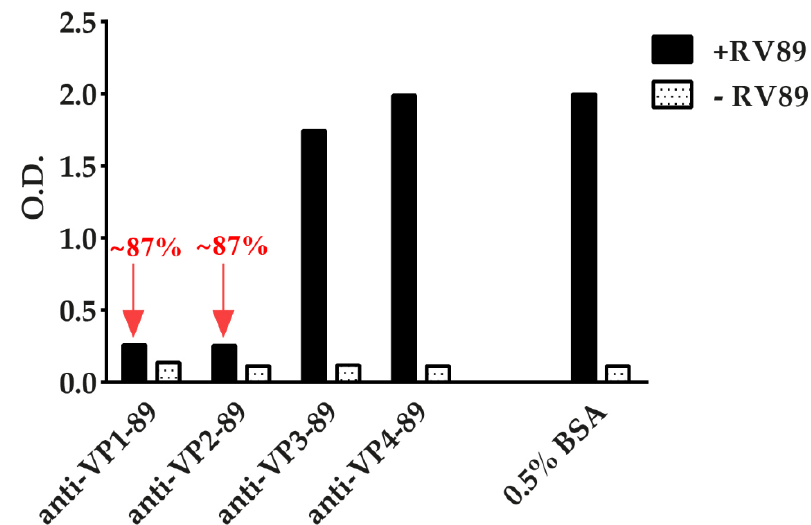
Figure 8. Inhibition of RV89 binding to ICAM-1 by antibodies specific for each of the four viral capsid proteins (VP). Binding of RV89 to ICAM-1 after pre-incubation of virus with antibodies against VP1, VP2, VP3, and VP4 compared to pre-incubation with buffer containing BSA only reported as O.D. (y-axes). The inhibitions of RV89 binding by anti-VP1 and anti-VP2 antibodies are indicated by red arrows. Omission of RV89 served as a negative control. The results are means of duplicate determinations with a variation of less than 10%. Inhibition experiments were performed three times.